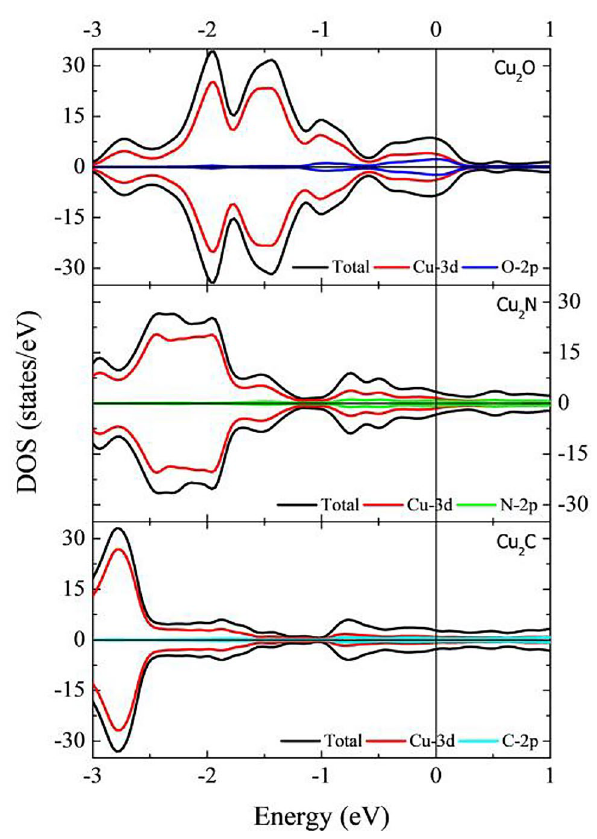
Figure 2. DOS and pDOS for the Cu 2 O, Cu 2 N and Cu 2 C MXenes. Fermi energy is set to 0